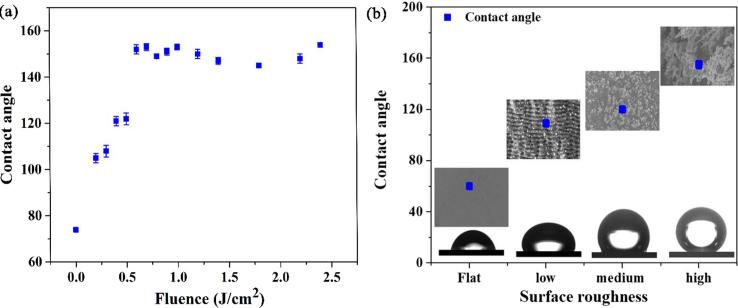
(a) The measured contact angle values as a function of laser fluence. (b) Contact angle values measured on the initial surface roughness at low fluence, low, medium and highly-dense surface structures and corresponding surface morphologies are depicted in the insets.